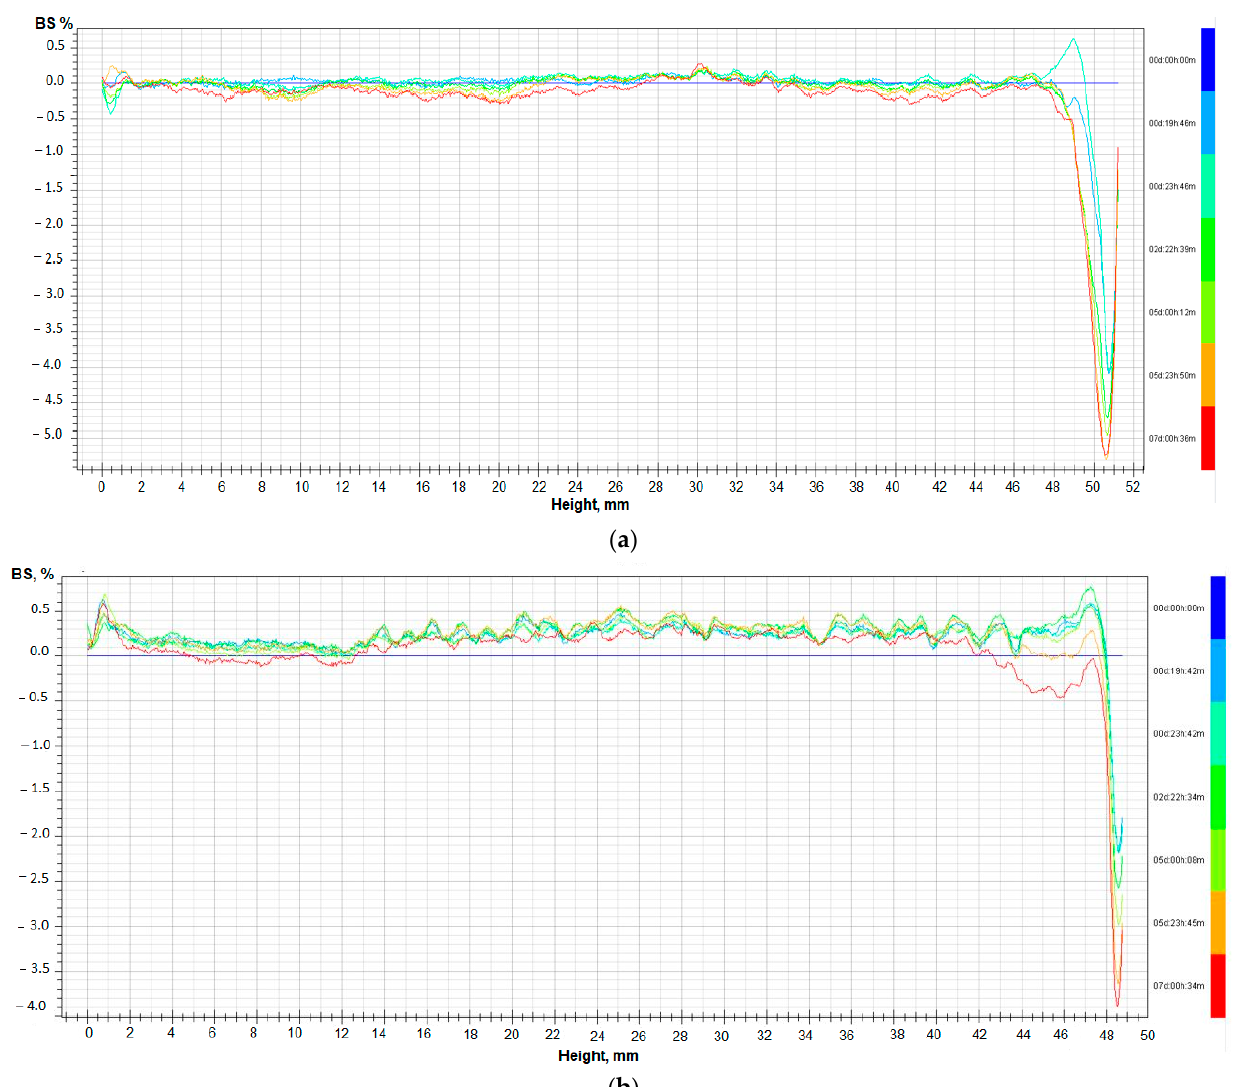
Figure 4. The variation of the delta backscattering of agar gel ( a ) and gel with oil and 1% of lecithin ( b